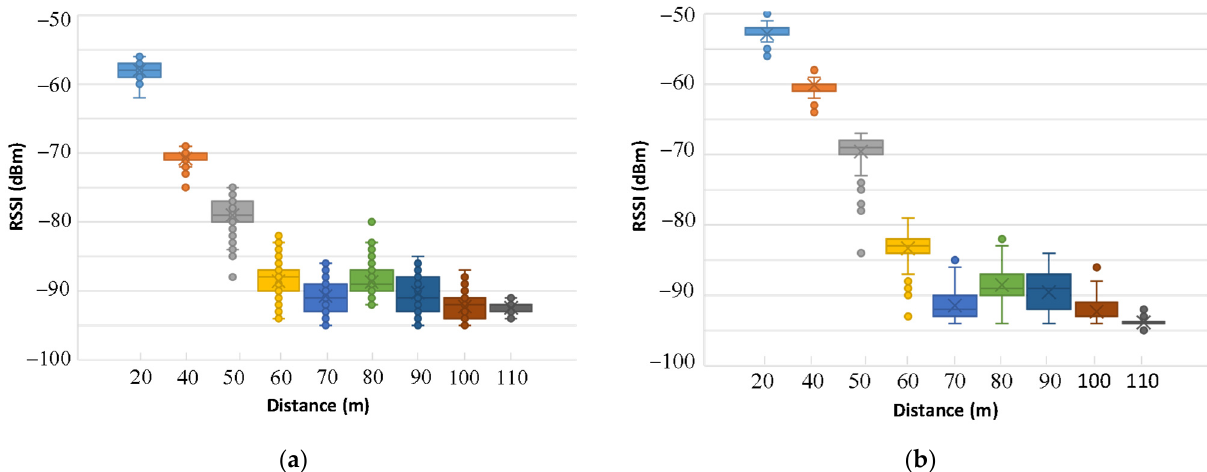
Figure 11. RSSI measurements: ( a ) omnidirectional antenna; ( b ) directional antenna.